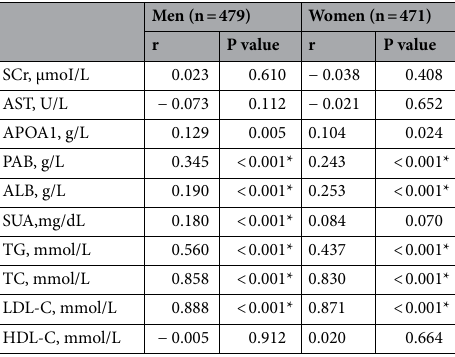
Table 4. Spearman correlation analysis to evaluate the association of APOB with metabolic factors by gender in AF patients. Data were presented as mean ± SD. Abbreviations as in Table 1. *Statistically significant value (P < 0.05).